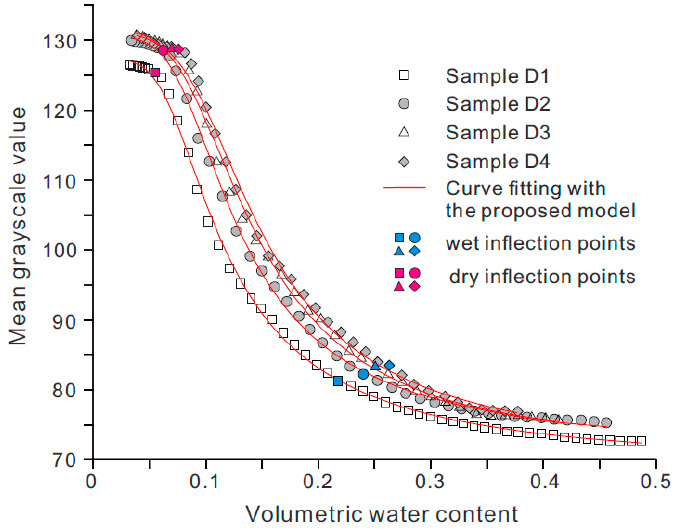
Figure 7. WGCCs for samples with different dry densities.